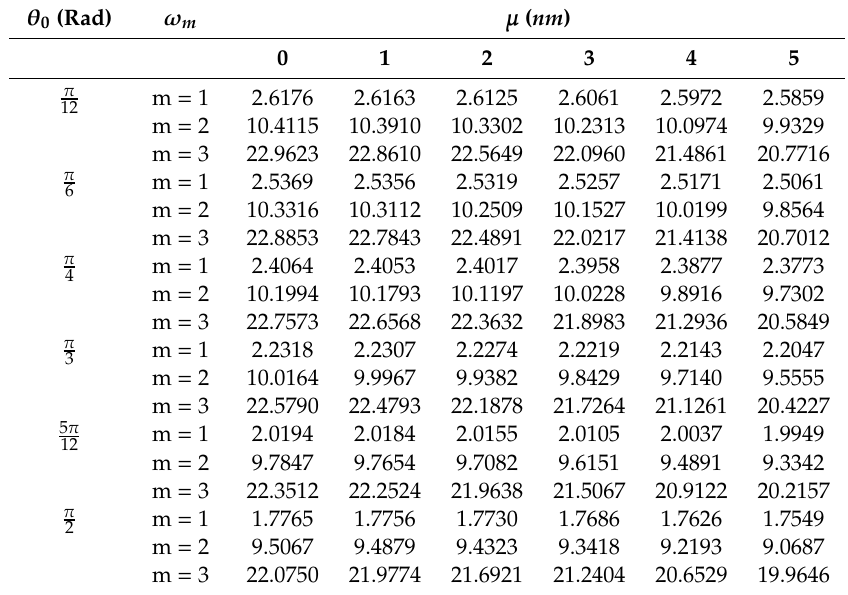
Table 7. Variation of the first three natural frequencies (GHz) with the opening angle and nonlocal parameter. θ ω m 0 (Rad)